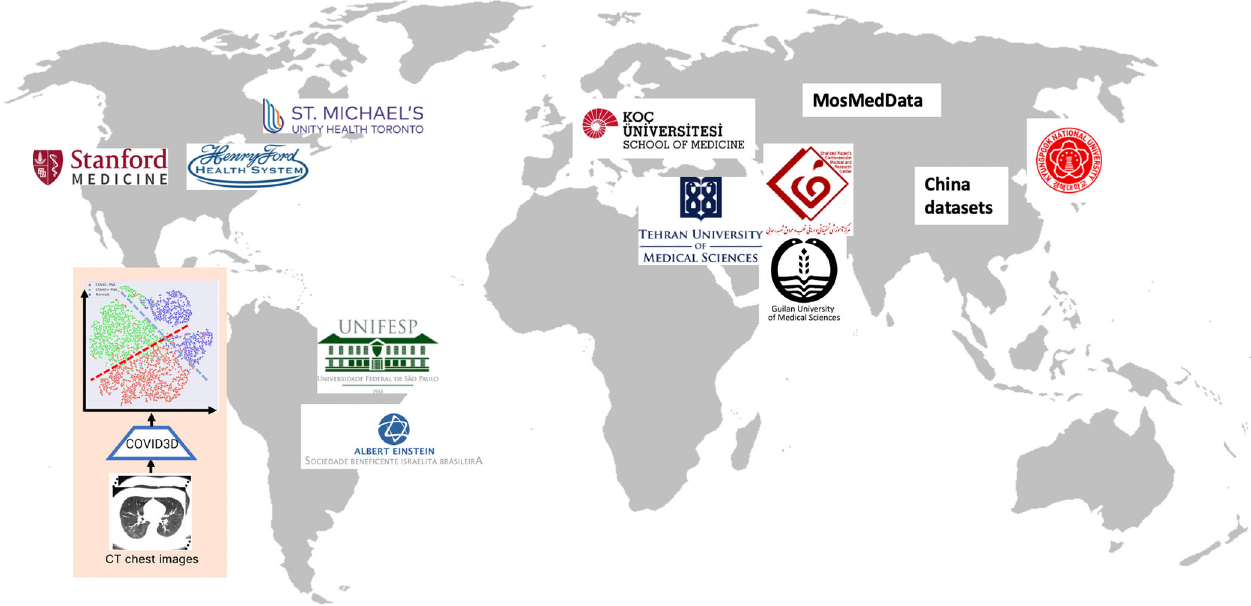
Fig. 1 Institutions used in our study. Our AI model (DCD) captures the diversity of patients, labels, and scanners from around the world. Permission was sought and granted by all relevant institutions to use their logos.